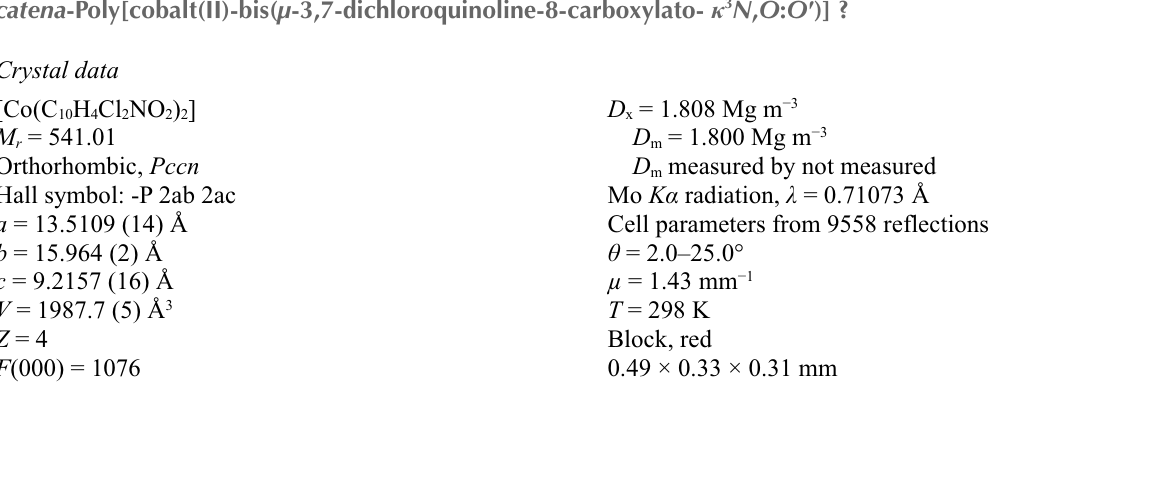
sup-2 Acta Cryst. (2008). E 64 , m227